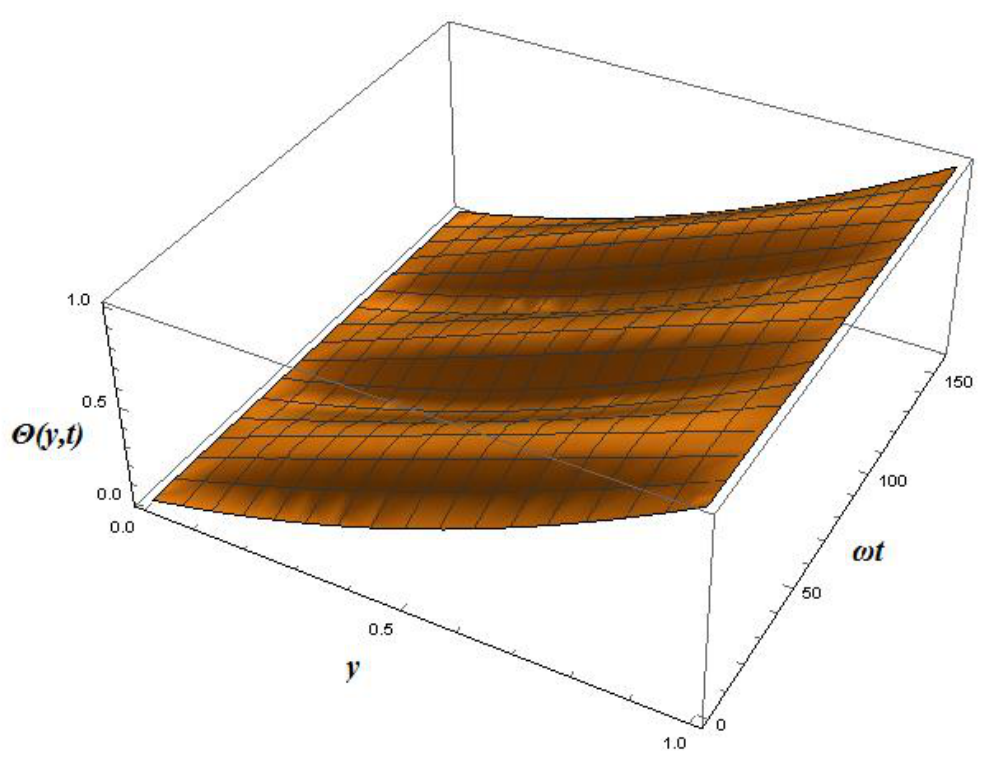
Figure 3. The 3D presentation of temperature distribution at time level ω t ∈ ( 0,50 π ) , when ω = 0.2, m = 0.10, M = 0.2, W e = 0.1, Ec = 9. Appl. Sci. 2017 , 7 , 369